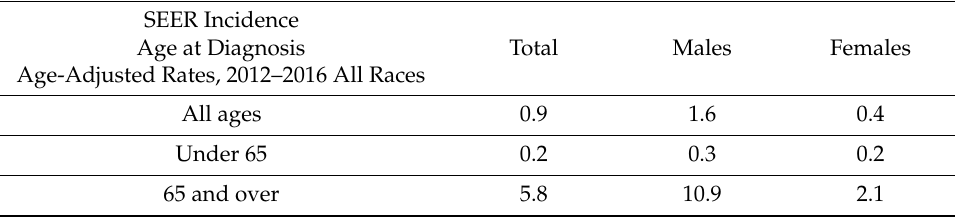
Table 3. SEER 2012–2016 incidence rates by sex and age.